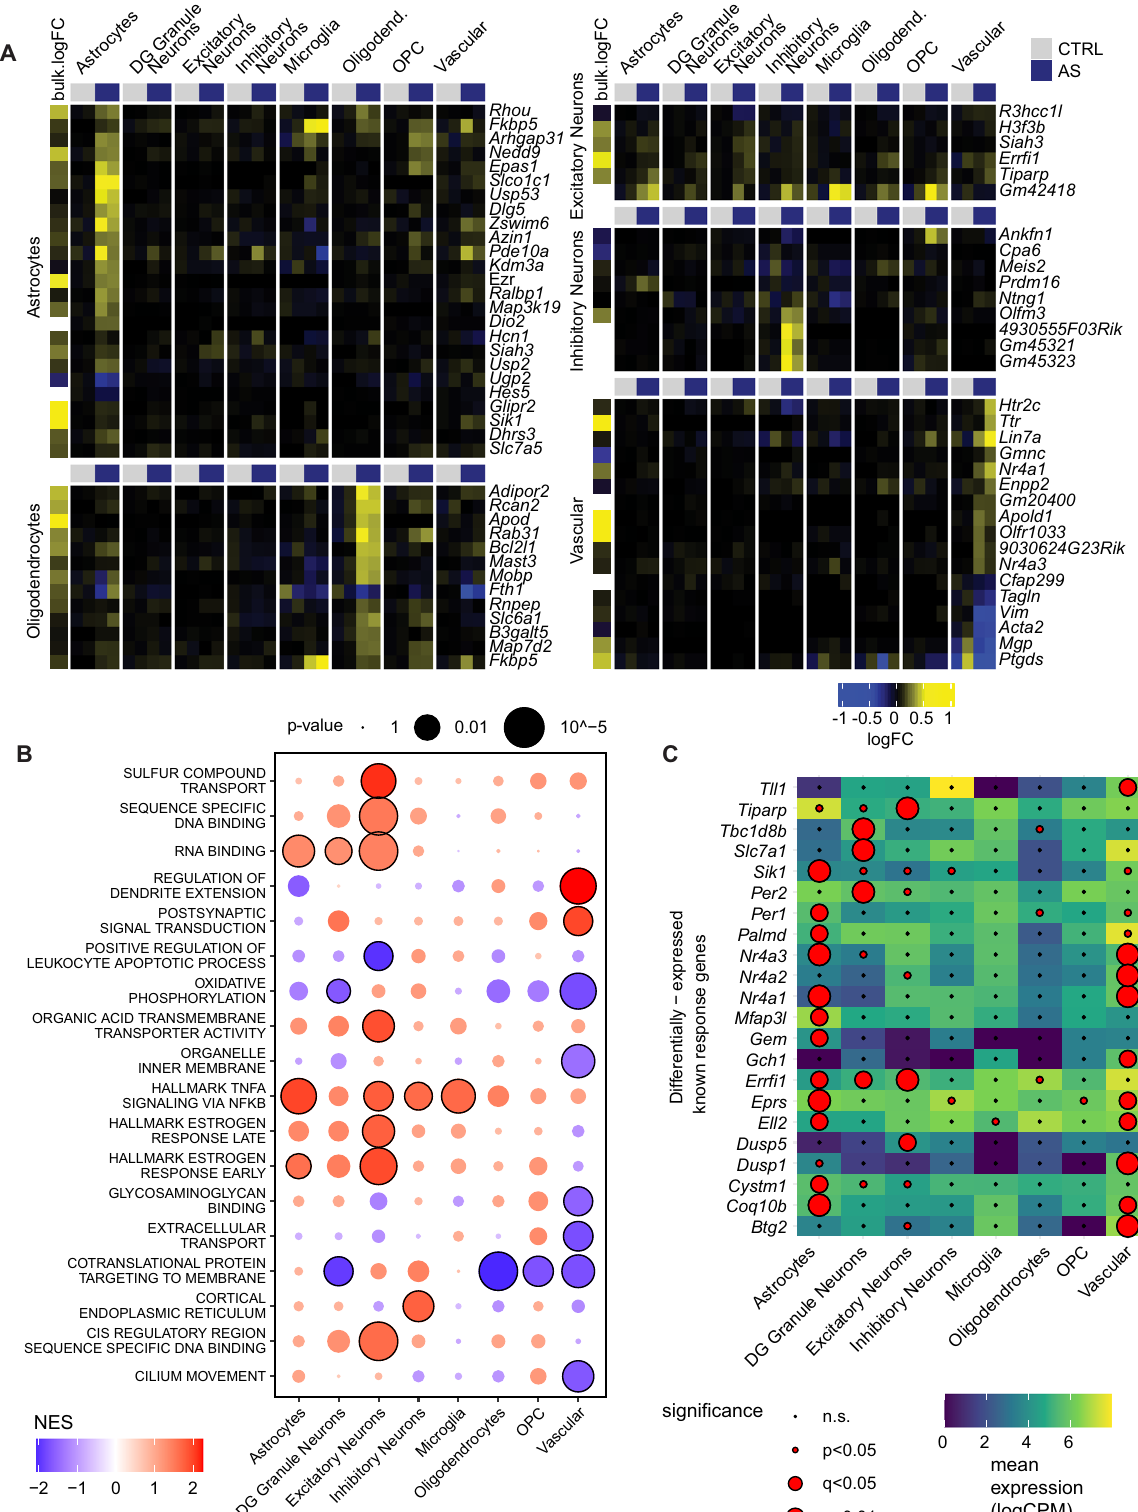
Fig. 5 Differential expression analysis of snRNA data 45 mins after acute stress (AS). A Top gene candidates from the differential expression analysis in snRNAseq. Each heatmap shows the top candidates of a selected cell-type and their expression in single-nuclei aggregated by cell type. At the left of each heatmap is the logFC in unprocessed bulk samples 45 mins after AS (white indicates insuf fi cient data). B Gene set enrichment analysis (GSEA) on the stress signature across cell populations. To avoid redundant terms, the union of top signi fi cant terms across cell types were clustered based on gene memberships and the most signi fi cant term per cluster was retained. C known activity-induced response genes (from 50 , with their signi fi cance vs mean expression levels in different cell populations. Experiments performed in male mice. NES normalized enrichment score, CPM counts per